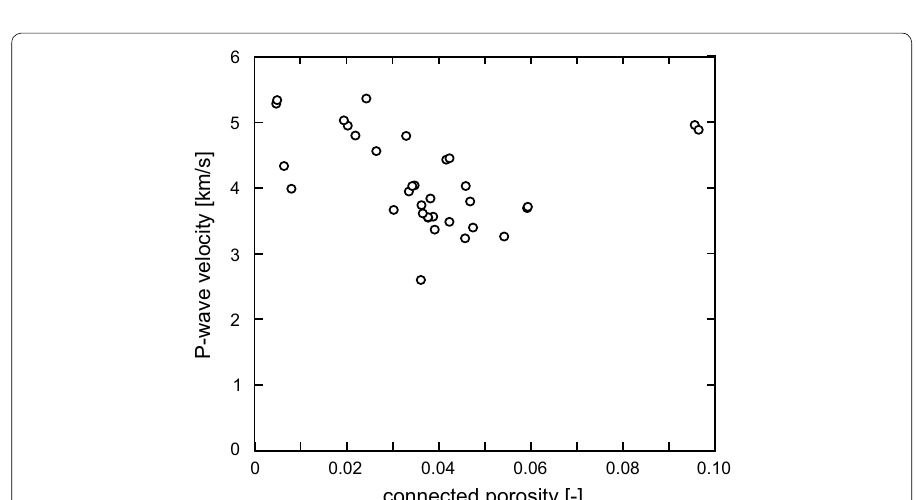
heat capacity of the Muschelkalk samples are plotted as a function of porosity in Fig. 7 (data available in Table 3). The thermal conductivity, thermal diffusivity, and specific heat capacity range, respectively, from 2.42 to 5.72 W/mK, 1.19 to 2.46 mm 2 /s, 1.63 to 2.46 MJ/m 3 K (Fig. 7). All three properties appear to decrease as a function of increasing porosity, although the trend is less clear for specific heat capacity (Fig. 7). Representa- tive uniaxial stress–strain curves for the Muschelkalk samples are provided in Fig. 8a. These uniaxial stress–strain curves are typical of those for rocks deforming in compres- sion (e.g., Eberhardt et al. 1999). Stress is initially a non-linearly increasing function of